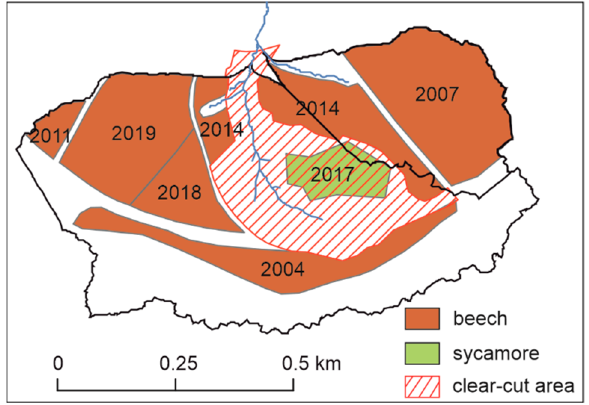
Figure 2. Planting areas of beech ( Fagus sylvatica L.) and sycamore trees ( Acer Pseudoplatanus L.) together with the planting year in the Wüstebach experimental catchment (according to unpublished data from the Eifel National Park) and the deforested area created in 2013.